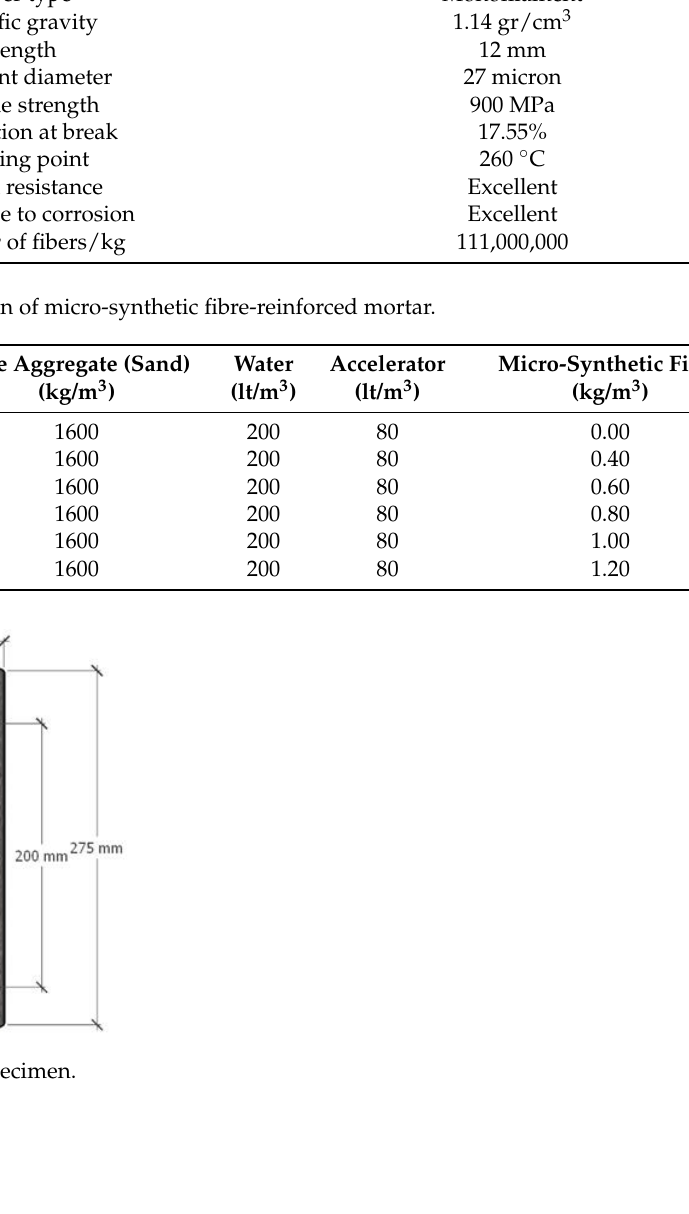
Figure 3. Measuring shrinkage with damage gauge. 4. Results and Discussion 4.1. Shrinkage Development with Time The measured shrinkage of the micro-synthetic fiber-reinforced mortars is presented in Figure 4. The results indicate that a very rapid shrinkage development occurs at an early age. The 3-day shrinkage of the mortars is already in the range of 40 – 50% of the 84- day shrinkage. After 14 days of age, the development of shrinkage is almost negligible; the 14-day shrinkage of the mortars already attains about 95 – 98% of the 84-day shrinkage. The nearly horizontal trend of the shrinkage curves after 14 days also suggests that the difference between the 84-day shrinkage and the ultimate shrinkage value is trivial. The above shrinkage behavior is very dissimilar to normal concrete shrinkage. Gen- erally, the shrinkage of concrete increases at a diminishing rate [26]. However, the devel- opment of normal concrete shrinkage at an early time is not as rapid as that of the micro- synthetic fiber-reinforced mortar. The ACI 209.2R-08 suggests that the shrinkage half-time is achieved at 35 to 55 days depending on the curing time and type. This range of the shrinkage half-time is obviously longer than the observed shrinkage half-time of the mi- cro-synthetic fiber-reinforced mortar. Apparently, half of the ultimate shrinkage value of